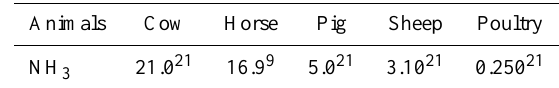
Table 10. Ammonia emission factors of animals (units: kgyr − 1 ). Animals Cow Horse Pig Sheep Poultry